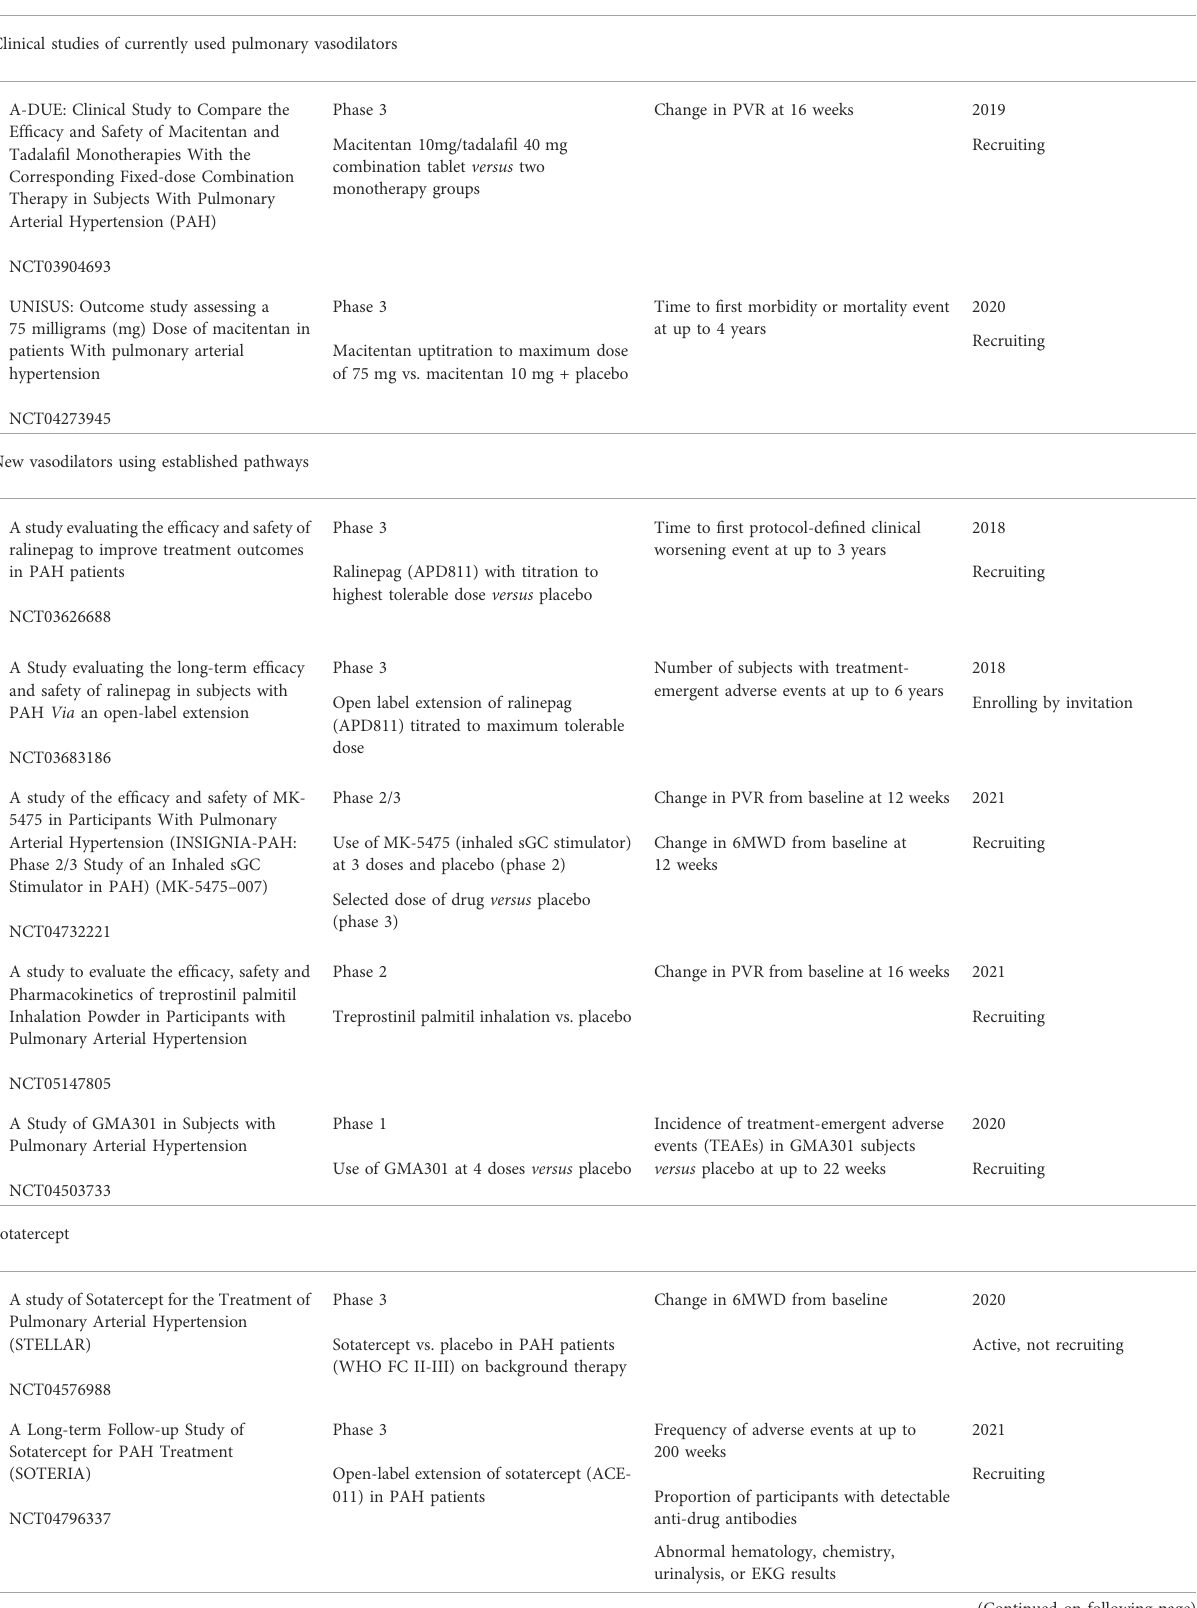
TABLE 2 Selected active therapeutic trials in pulmonary arterial